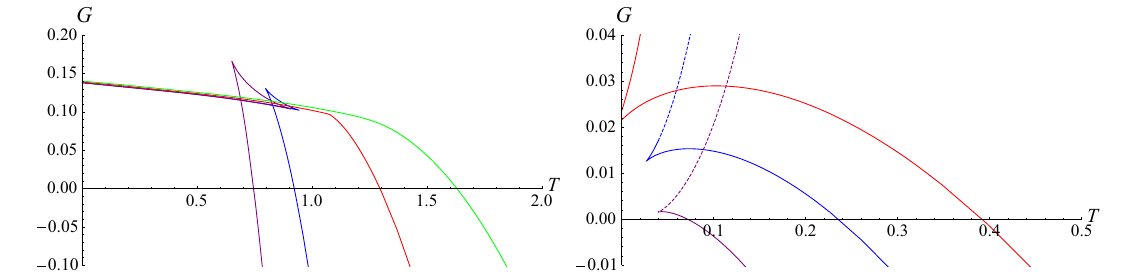
Fig. 9 Plots of the Gibbs free energy for the positive effective hori- zon curvature (left) and the zero one (right). Left panel: the purple, blue, red and green curves correspond to P = 0 . 3, 0 . 5, 1 . 1353 ( P c ) , 2, respectively, at m = c = c 1 = c 2 = 1 and k = 0 . 1. Right panel: the